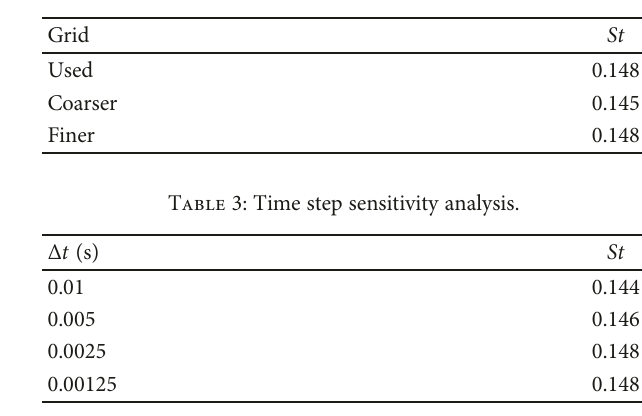
Table 2: Grid sensitivity analysis.